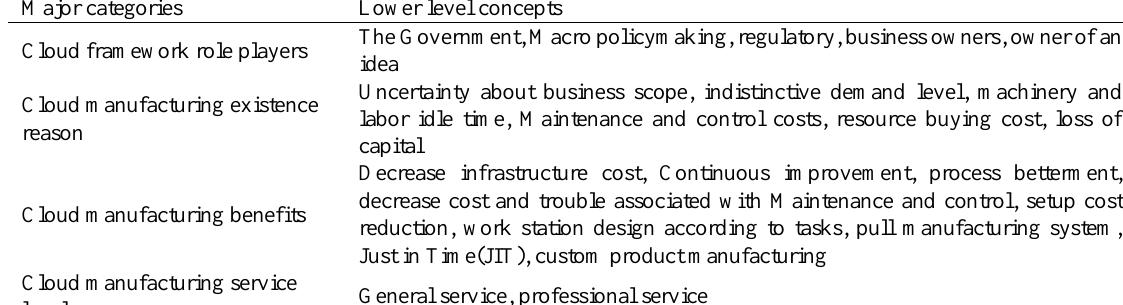
Table 1. Major categories and lower level